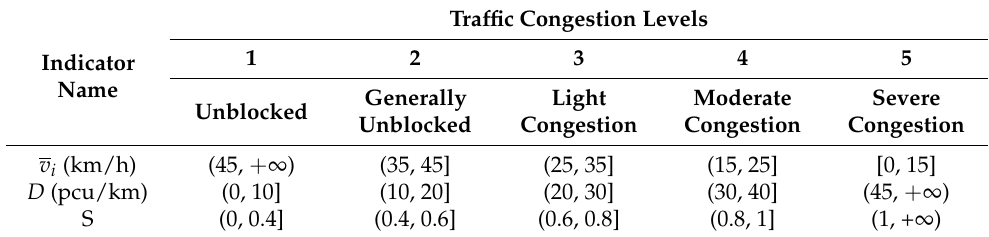
Table 2. The value range of the traffic congestion levels of the three indicators.